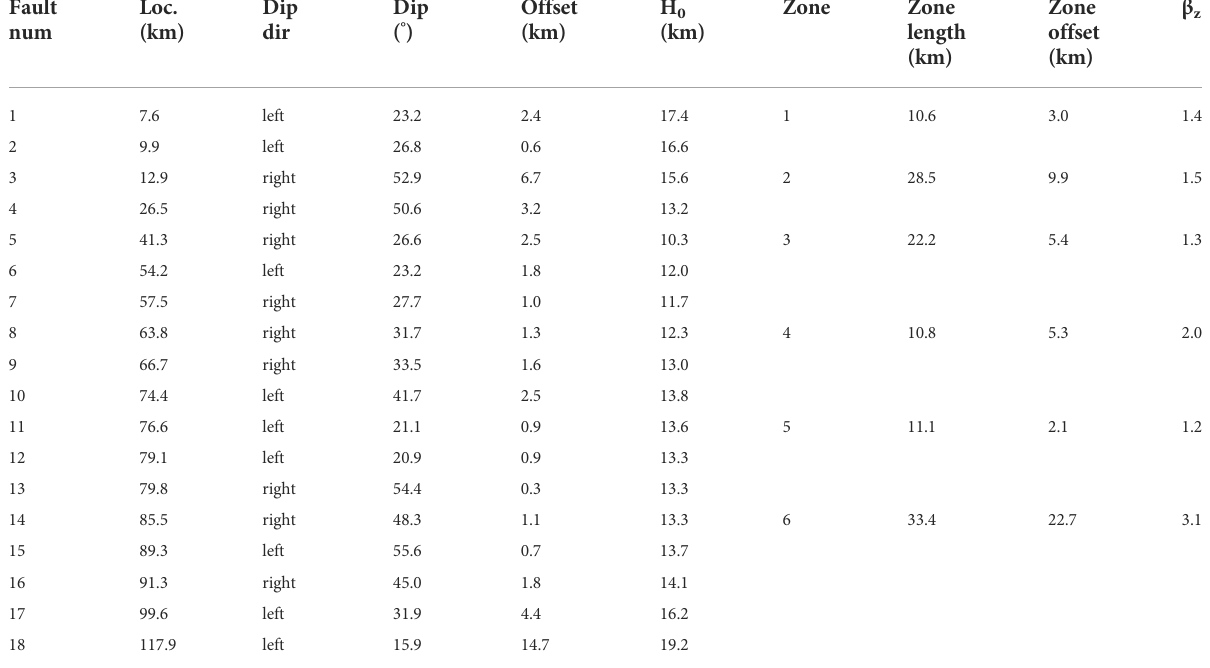
TABLE 2 Parameters of faults (F1 to F18 in Line 1; see location in Figure 2). Zone length, zone offset and β z of six zones (Figure 2B) are provided. Fault